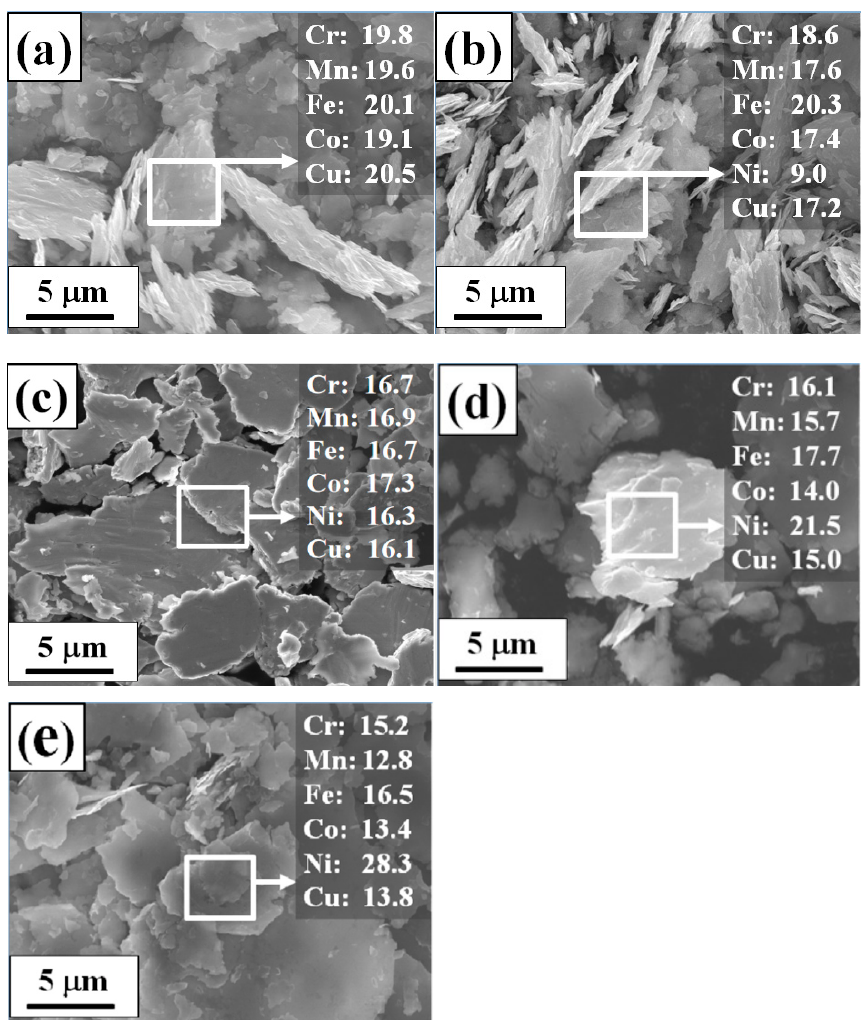
Figure 7. SEM photos of CoCrCuFeMnNi x HEAPs after 50 h ball milling: ( a ) Ni 0 , ( b ) Ni 0.5 , ( c ) Ni 1.0 , ( d ) Ni 1.5 , ( e ) Ni 2.0.